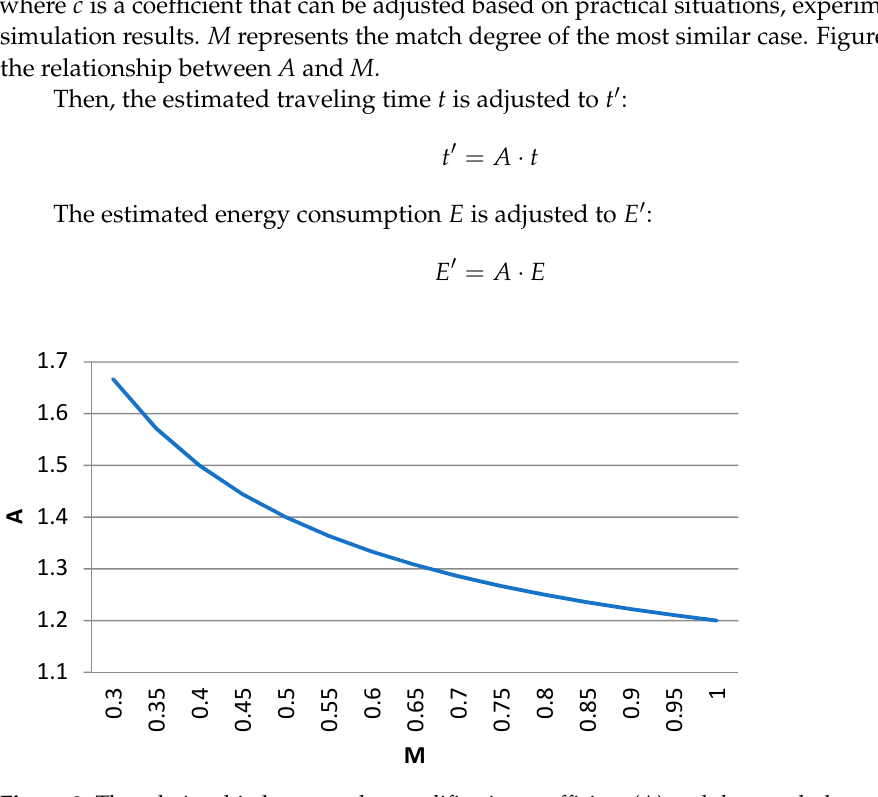
Figure 3. The relationship between the amplification coefficient (A) and the match degree (M).